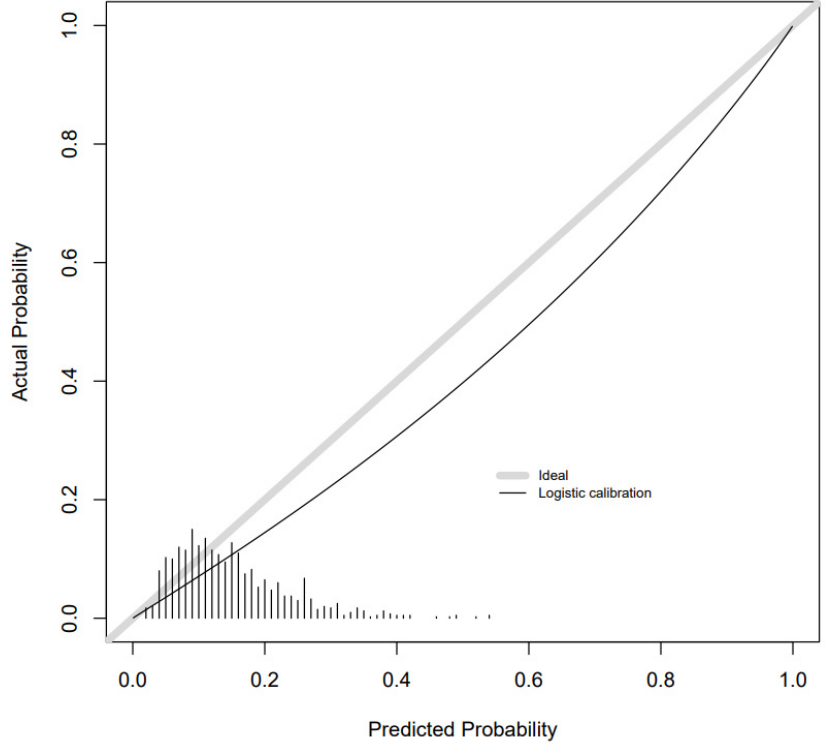
Figure 3. Calibration slope for LGA combined model in BiB 1000 testing sample.